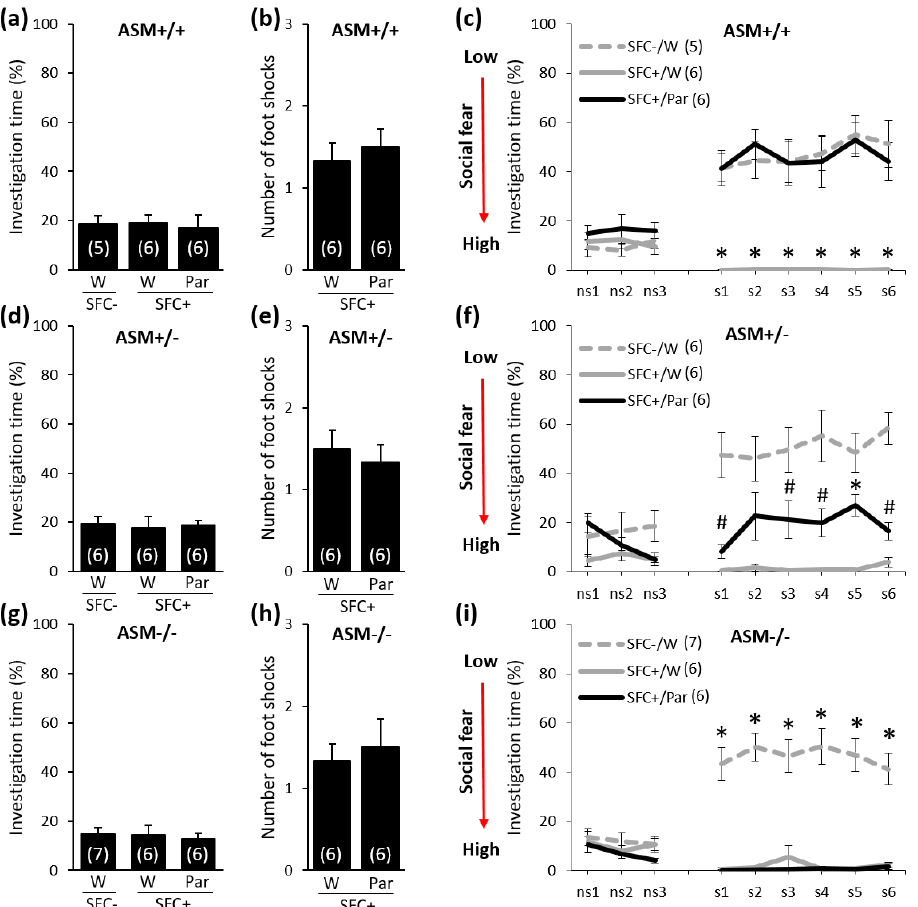
Figure 1. Chronic paroxetine treatment (10 mg / kg / day for 14 days) reduces social fear in ASM +/+ and ASM +/ − mice but not in ASM − / − mice. ( a , d , g ) Preconditioning investigation of the non-social stimulus (empty cage) shown by unconditioned (SFC − ) and conditioned (SFC + ) mice during SFC on day 1. ( b , e , h ) Number of foot shocks received by SFC + mice during SFC. ( c , f , i ) Investigation of the